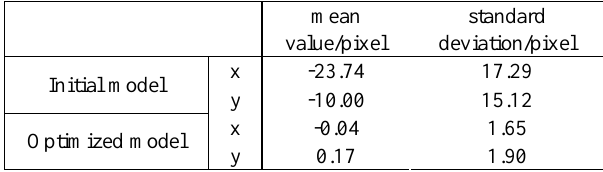
Table 1. Statistics of distances of vertexes